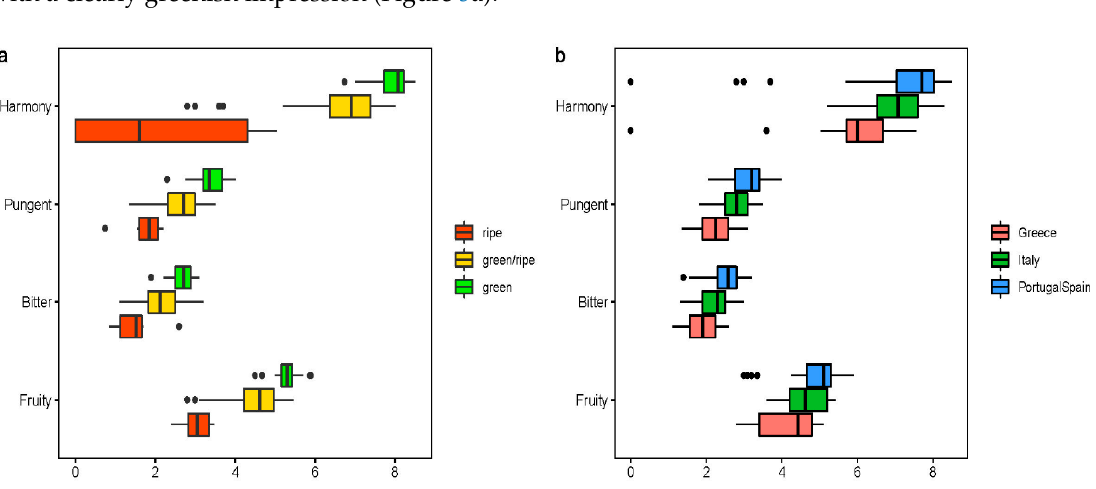
Figure 5. ( a ) The relation of the four main sensory descriptors harmony, pungent, bitter and fruity with the di ff erent ripening stages of the olive. ( b ) The relation of the four main sensory descriptors harmony, pungent, bitter and fruity with the di ff erent manufacturing countries. Di ff erent scales units must be taken into account for the x-axis with fruity, bitter, pungent: 0 = not detectable to 10 = intense; harmony: 0 = no harmony to 5 = standard harmony to 10 = excellent harmony.